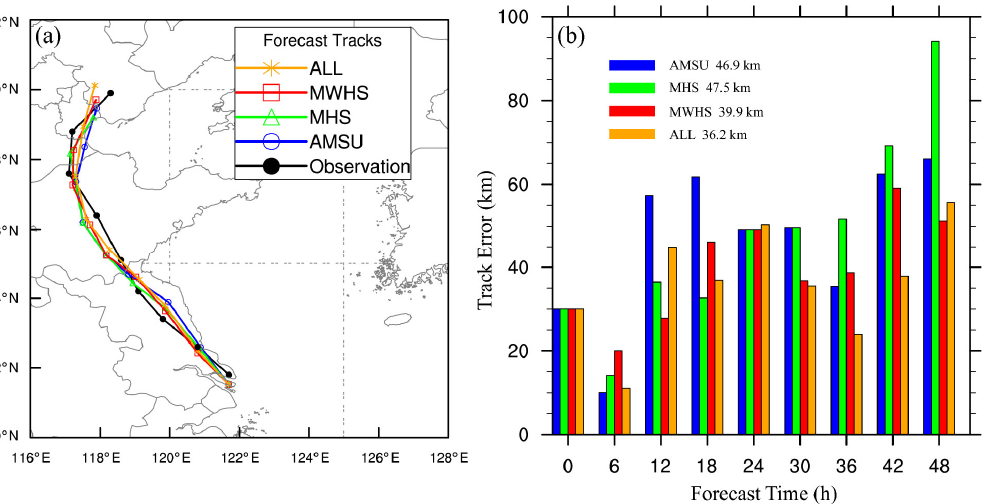
Figure 11. ( a ) The track and ( b ) the track error (km) of Typhoon Ampil in the 48-h forecast initialized at 0600UTC on 22 July 2018.